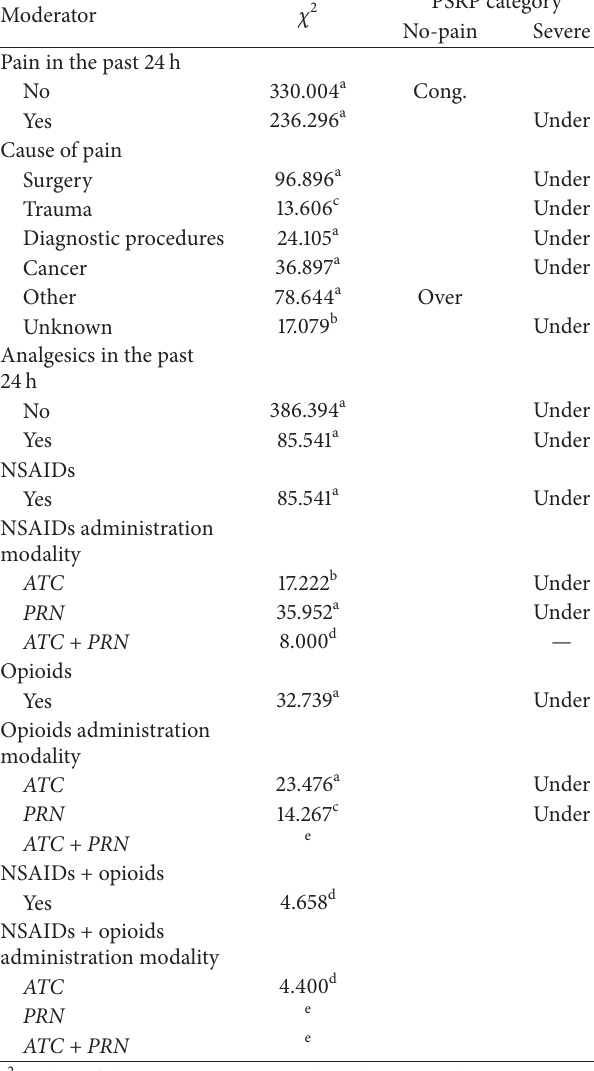
Table 3: Congruence categories dependence upon the PSRP cate- gory split by congruence